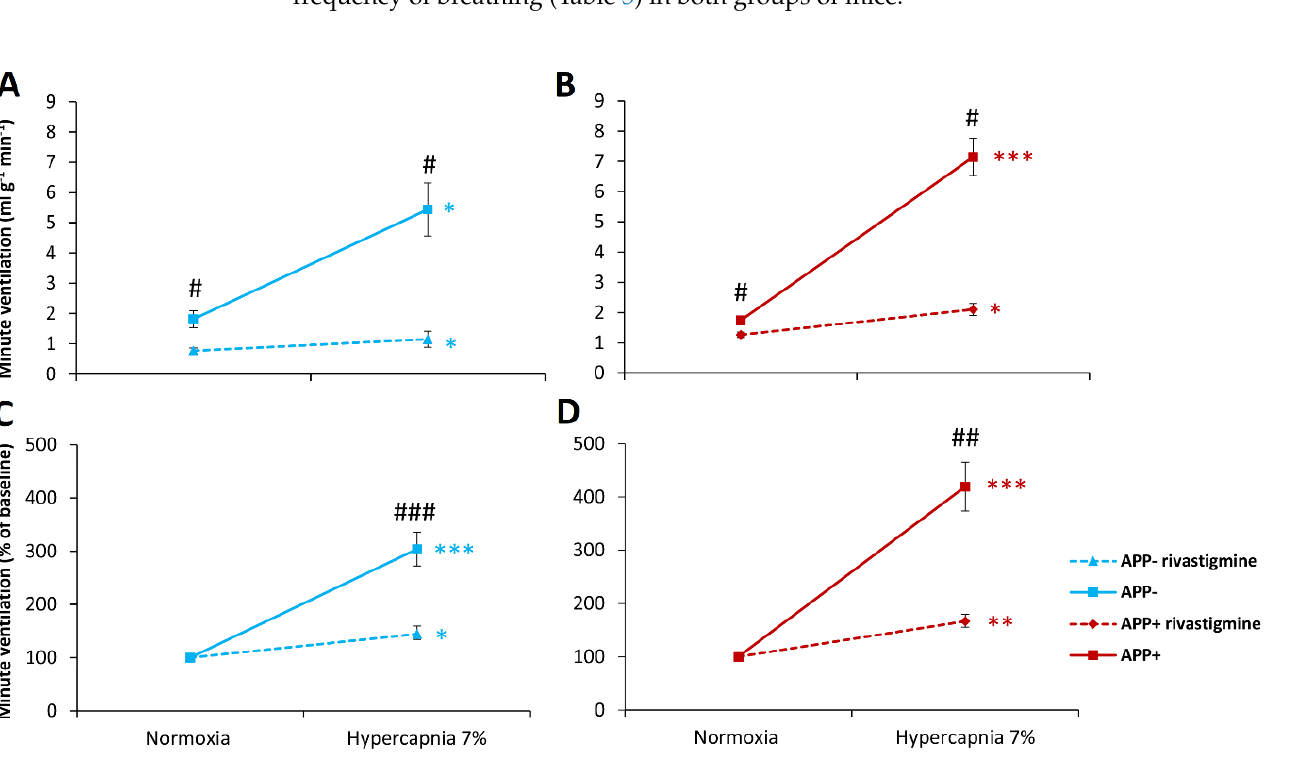
Figure 5. Minute ventilation (V E ) during air breathing (normoxia) and ventilatory response to hypercapnia in APP+ (red line) and APP − mice (blue line) before (solid line) and after rivastigmine injection (dashed line) ( A , B ). Minute ventilation expressed as a percentage of baseline (normoxia) values ( C , D ). Note the significantly reduced hypercapnia reactivity in both groups of mice. The data are presented as mean ± SEM; * p < 0.05, ** p < 0.01, *** p < 0.001 vs. normoxia value. # p < 0.05, ## p < 0.01, ### p < 0.001 vs. pre-memantine state (n = 6 for APP+ and APP − ).